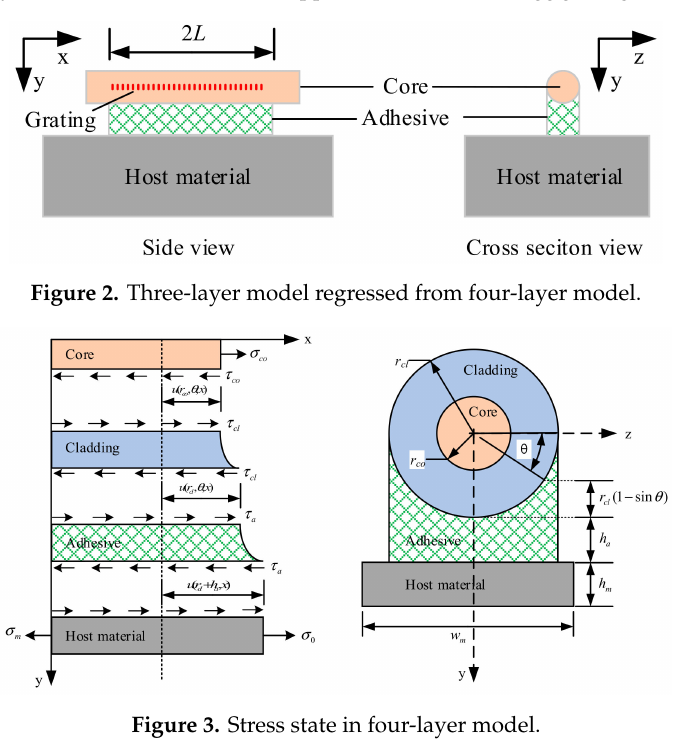
Figure 1. Four-layer model of surface-bonded sapphire-derived fiber Bragg grating (SDFBG) test system.